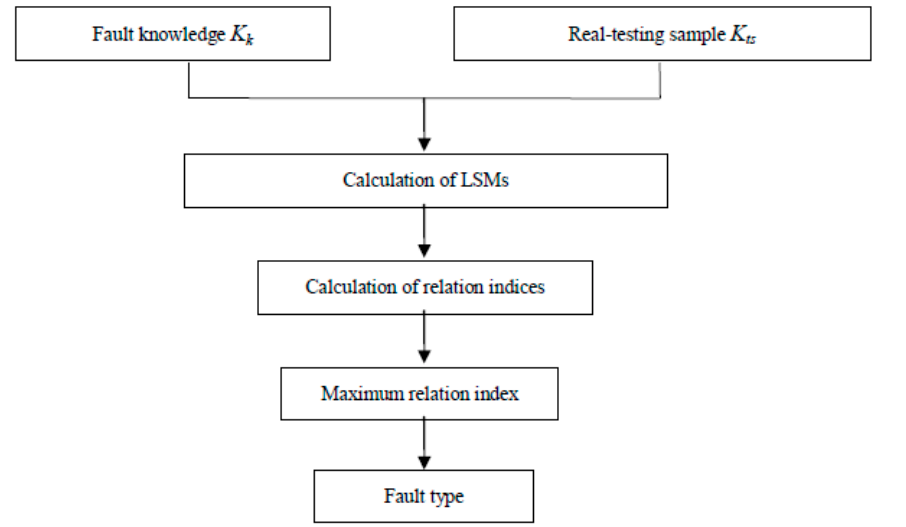
Figure 1. Block diagram of fault diagnosis corresponding to the LSM of IVFSs and relation indices.